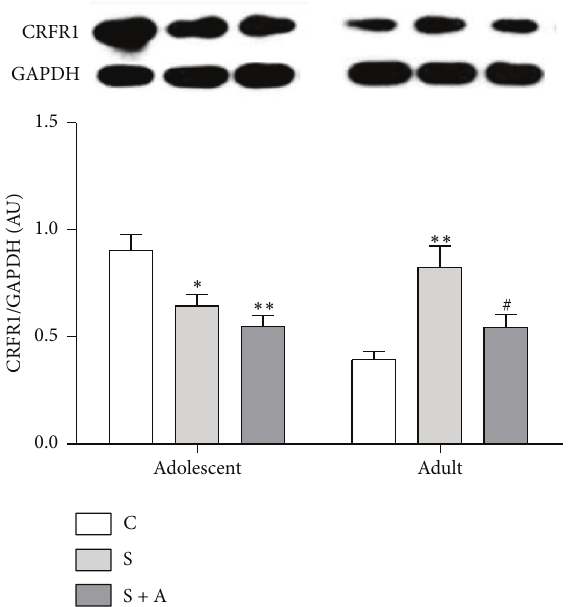
Figure 4: Representative images of Western blotting for CRFR1 expression in adolescent and adult hypothalamus. Values were expressed as mean ± SEM. ∗ and ∗∗ indicate 𝑝 < 0.05 and 𝑝 < 0.01 versus CON, respectively; # indicates 𝑝 < 0.05 versus S.